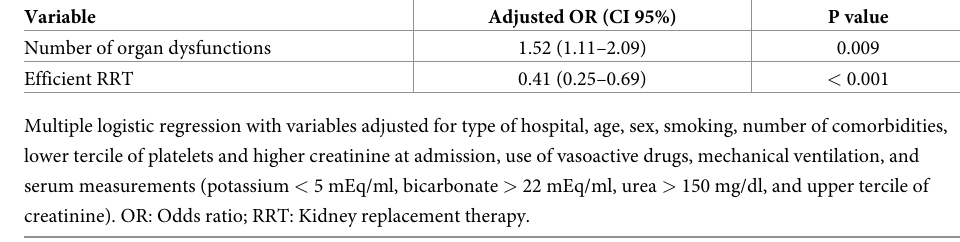
Table 5. Multivariate analysis of factors related to death.